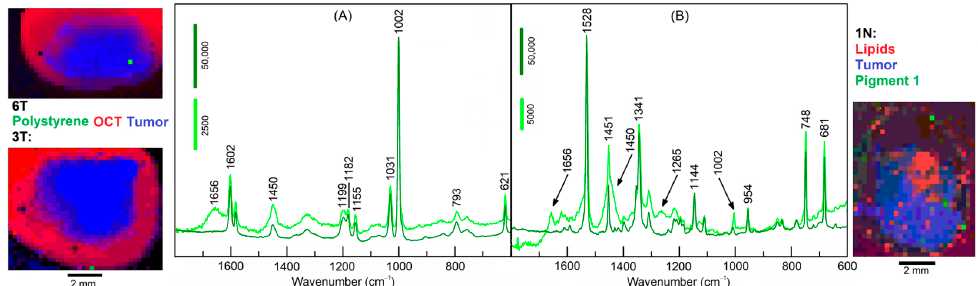
Figure 6. Endmember spectra obtained from VCA of polystyrene in specimens 3T and 6T ( A ) and pigment 1 in specimen 1N ( B ). Color-coded abundance plots show the location of polystyrene and pigment 1 (green), tumor (blue), and optimal cutting temperature medium (OCT) in ( A ) and lipids in ( B ) (red). Whereas pure pigment spectra are obtained at few locations with high intensities (dark green), spectral contributions of tissue are evident in the less intense pigment spectra (light green).